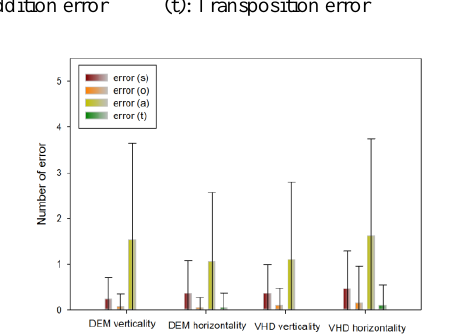
Figure 10. Error occurrence in DEM and VHD(*: